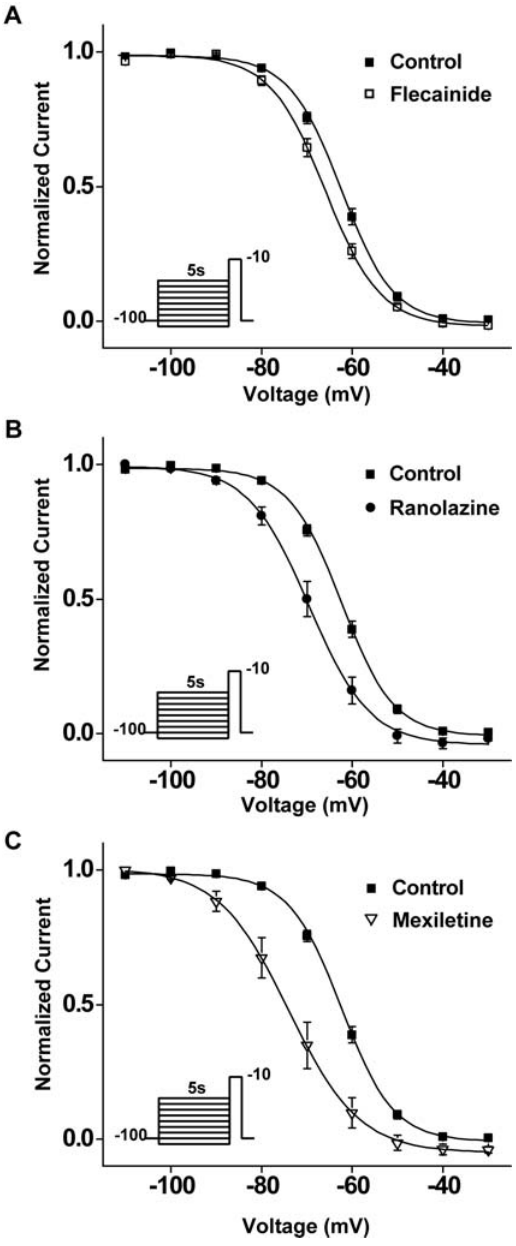
Figure 6. Mexiletine and Ranolaziine, but not Flecainde, correct mutation-induced voltage shift in steady state inactivation. Steady state inactivation was measured with a 5s conditioning pulse (see Methods S1) followed by a brief 2 10 mV test pulse. A. Flecainide (n=4) did not significantly alter V 1/2 or slope factor of the channel availability curve. B–C. Mexiletine (n=5) and Ranolazine (n=9) each caused significant hyperpolarizing shifts in the voltage-dependence of steady- state inactivation (Table